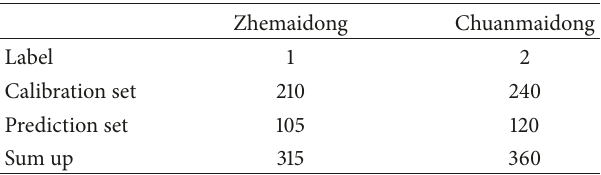
Figure 3: Seven wavelengths were selected by RC method. Table 1: Class assignment and division of Ophiopogon japonicus